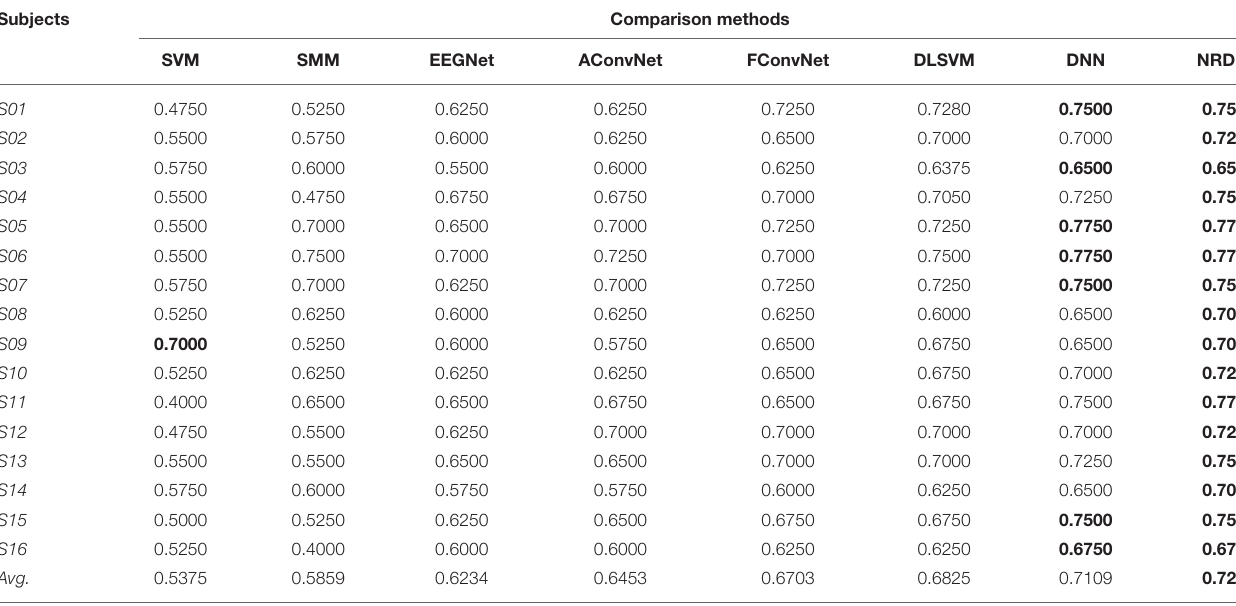
TABLE 3 | Classification performances (ACC) of our NRDNN against the comparison methods. Subjects